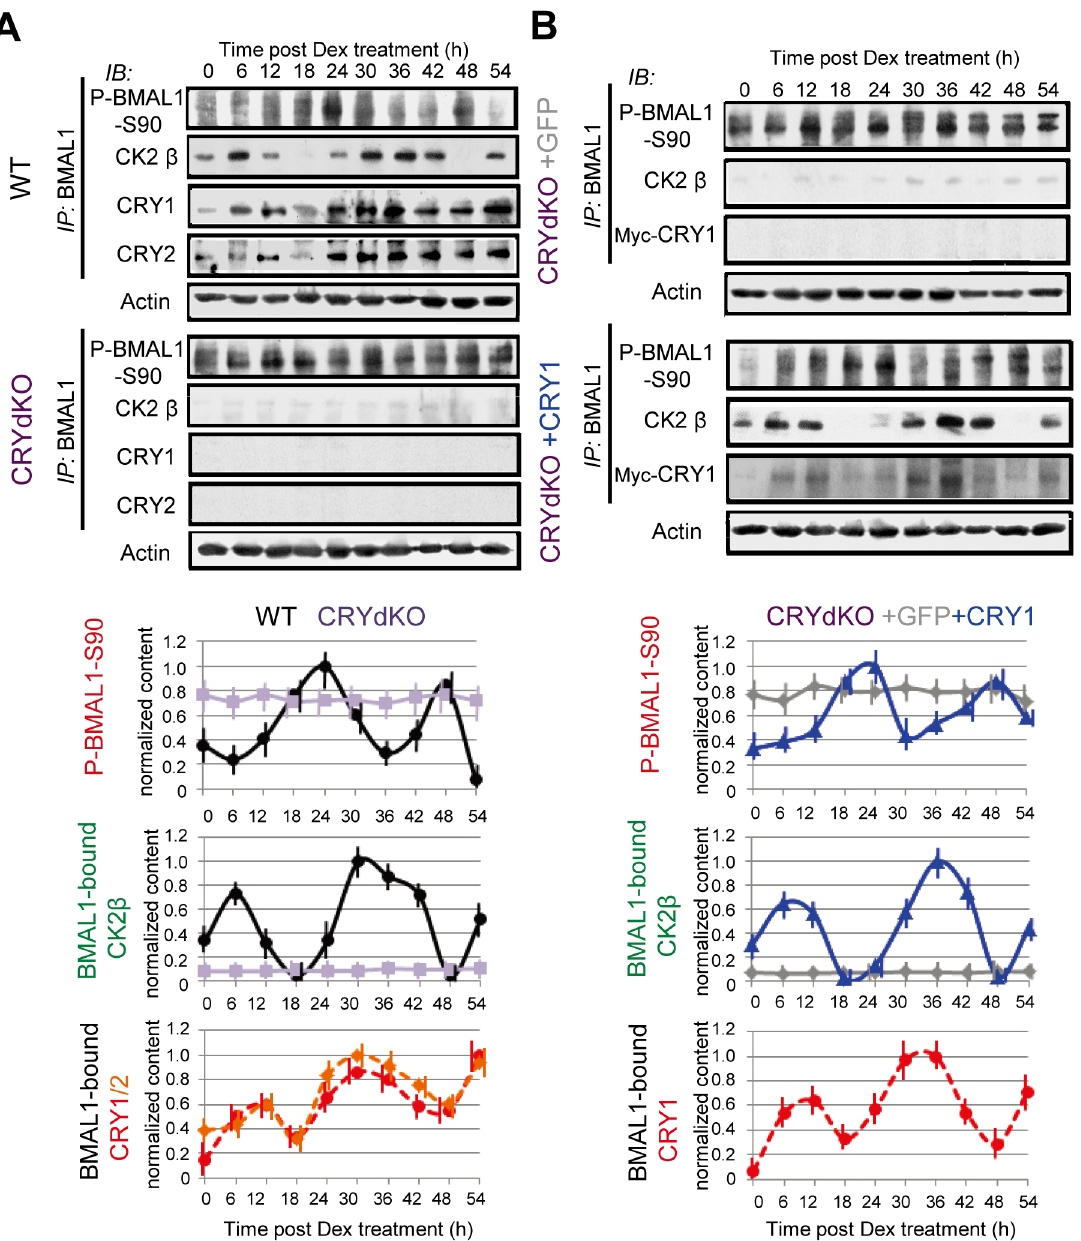
Fig 3. CRY is required for circadian CK2-mediated BMAL1-Ser90 phosphorylation, with inverse phase to BMAL1 – CK2 β binding rhythm. BMAL1 phosphorylation and CK2 β , CRY1, and CRY2 interaction profiles in wild type (WT), CRYdKO ( Cry1 -/- /Cry2 -/- ) MEFs (A) and CRYdKO MEFs stably expressing mCry1 promoter-driven Myc-CRY1 or CMV-promoter-driven Myc-GFP (control) (B). Cells were Dex-synchronized and harvested at 6 h intervals. BMAL1-IP and lysates were subjected to IB analysis for P-BMAL1-S90, CK2 β , CRY1, CRY2 and actin (loading control). Shown are representative examples of n = 3 experiments (upper panels). P-BMAL1-S90 and BMAL1-bound CK2 β , CRY1 and CRY2 levels were quantified and normalized against actin levels (lower panels). Maximum values in WT/CRYdKO+CRY1 were set as 1. Error bars indicate